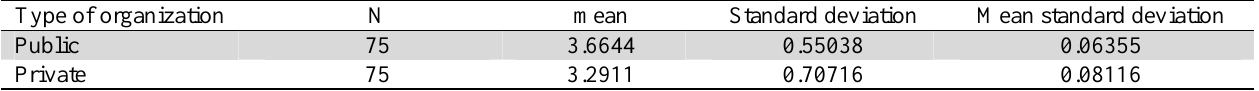
Mean standard deviation Standard deviation mean N Type of organization